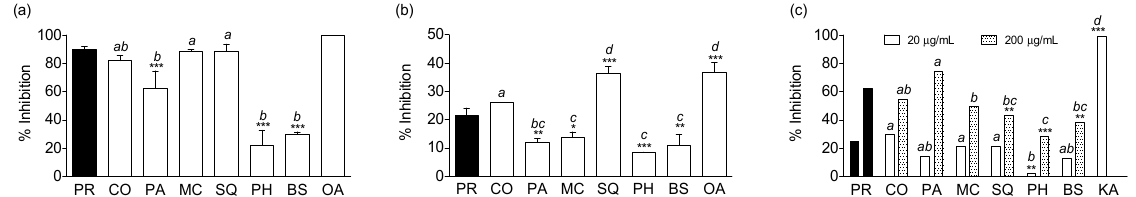
Figure 2. Skin protective properties of cocoa samples. ( a ) Percentages of inhibition for collagenase; ( b ) Percentages of inhibition for elastase; ( c ) Percentages of inhibition for tyrosinase. In the enzyme inhibition, the values are expressed as the mean ± SD; BS: cocoa bean shell; CO: ordinary cocoa bean; KA: Kojic acid; MC: musty cocoa bean; OA: oleanolic acid; PA: pasilla; PH: cocoa pod husk; PR: premium cocoa bean; and SQ: second quality cocoa bean. Different letters indicate significant differences ( p < 0.05) between cocoa samples (Bonferroni’s multiple comparison test). For each cocoa sample, asterisk denotes significantly difference in comparison with the control PR (Dunnett’s multiple comparison test; * p < 0.05, ** p < 0.01 and *** p < 0.001).